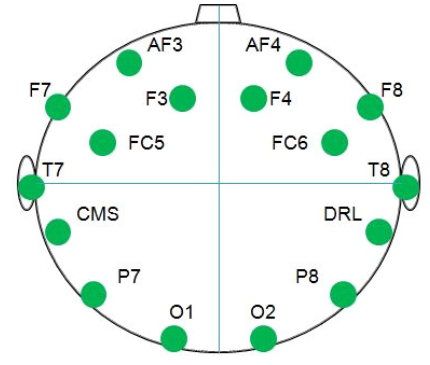
Figure 3. Electrode